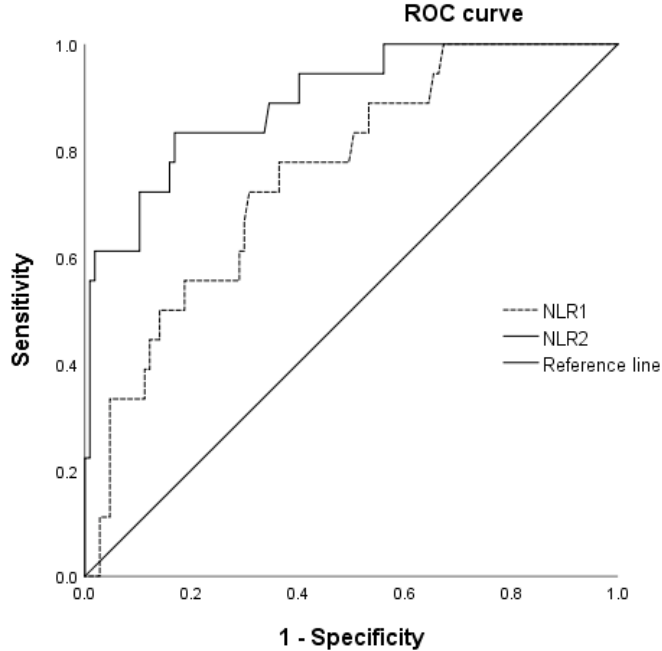
Figure 2. Receiver operating characteristic curve for NLR as a predictor of severe post-ERCP pancreatitis. ERCP, endoscopic retrograde cholangiopancreatography; NLR 1, neutrophil–lymphocyte ratio on day 1 post-ERCP; NLR 2, neutrophil–lymphocyte ratio on day 2 post-ERCP.